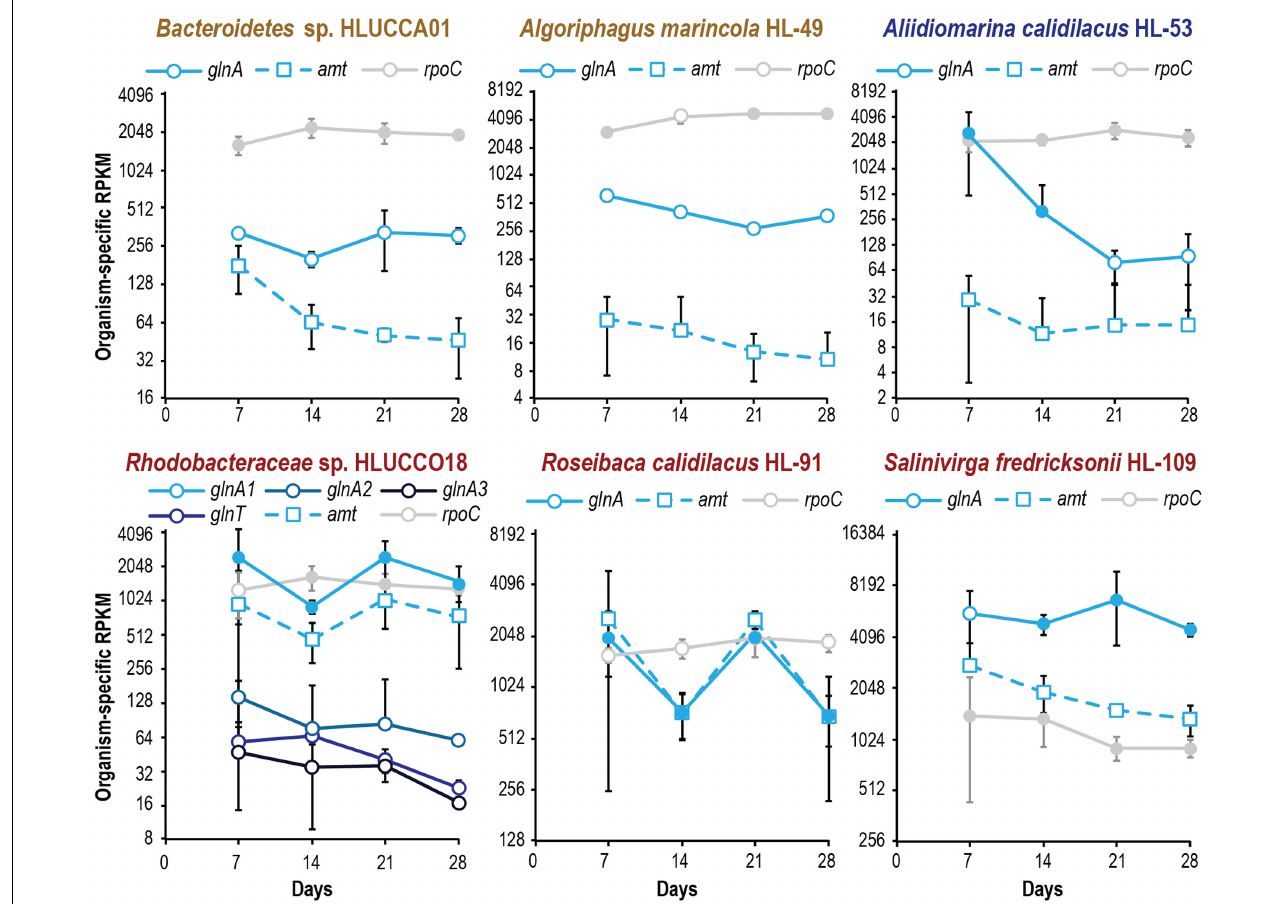
FIGURE 5 | Metatranscriptomic evaluation of ammonium incorporation gene expression in major heterotrophic species reveals species-specific patterns of nitrogen limitation during succession. Organism-specific RPKM is plotted on a log 2 scale; error bars indicate 95% confidence interval of the mean (where the 95% confidence interval is inclusive of zero or below, negative error bars are not shown). Filled symbols indicate that two or more peptides were observed for a gene’s product at a given time point; open symbols denote no or inadequate proteomic evidence. Expression of rpoC is included as a